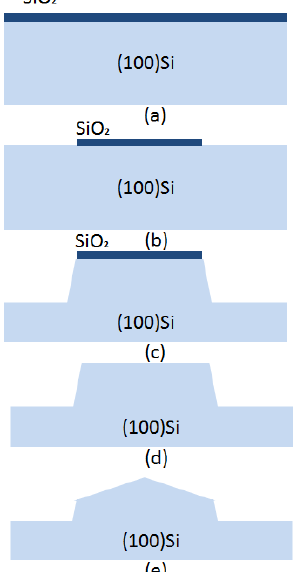
Figure 5. Two-step etching process. ( a ) a single(100) Si wafer with oxide layer; ( b ) the oxide mask patterned with a 30 μm diameter circular mask; ( c ) a circular table was formed by wet etching ; ( d ) the rest of the oxide layer mask was removed; ( e ) a second etching was performed to form final shape.